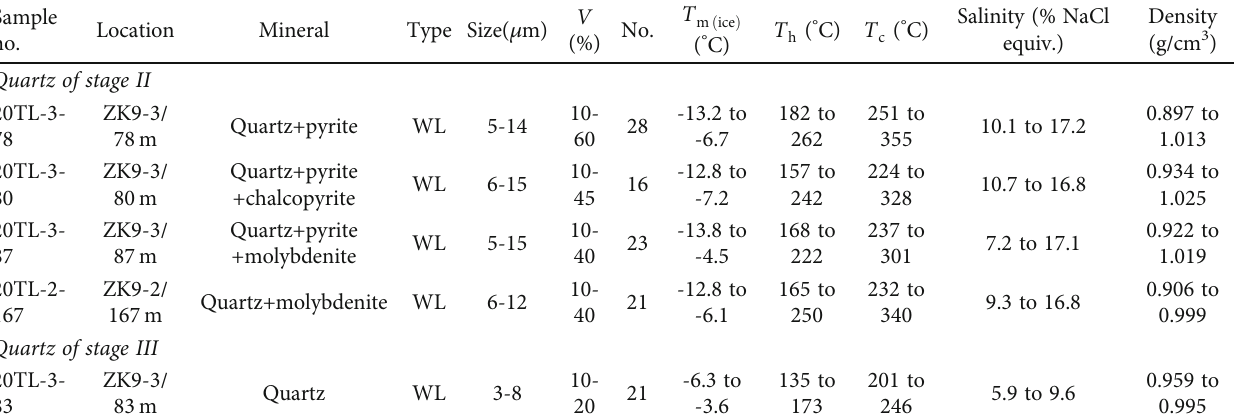
Table 2: Microthermometry data and relative parameters of fl uid inclusions in the Tieling deposit. Sample